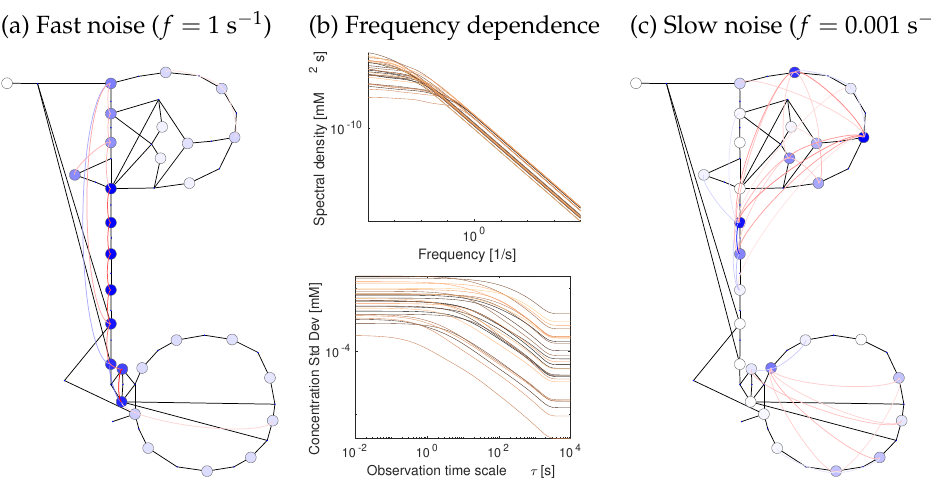
Figure 7. Metabolite fluctuations due to chemical noise. Chemical noise causes random fluctuations of metabolite concentrations and fluxes. In a chemical Langevin equation, chemical noise is modelled by adding white-noise terms to the reaction rates. Fast and slow fluctuations are damped differently in the network. ( a ) High-frequency metabolite fluctuations (spectral densities at oscillation freuency f = 1 s − 1 ) exist only close to the noise source. Circle colors show the spectral densities at 1 s − 1 , line colors show covariances (blue: positive; red: negative). ( b ) Metabolite fluctuations decrease with the frequency (see Figure 6). ( Top ): spectral densities, each curve corresponds to the variance of one metabolite over a range of frequencies. ( Bottom ): each curve corresponds to the standard deviation of a metabolite concentration (square root of spectral density, shown on the y -axis), computed for different time resolutions of observation ( x -axis). For details, see Supplementary Figure S5a. ( c ) Low-frequency metabolite fluctuations (oscillation period of 17 min) are correlated along the entire pathway. Results for flux fluctuations are shown in Supplementary Figure S5b. Smoothing at different time resolutions changes the variance of metabolite fluctuations. At low time resolutions, high-frequency fluctuations are filtered out (see Supplementary Figure